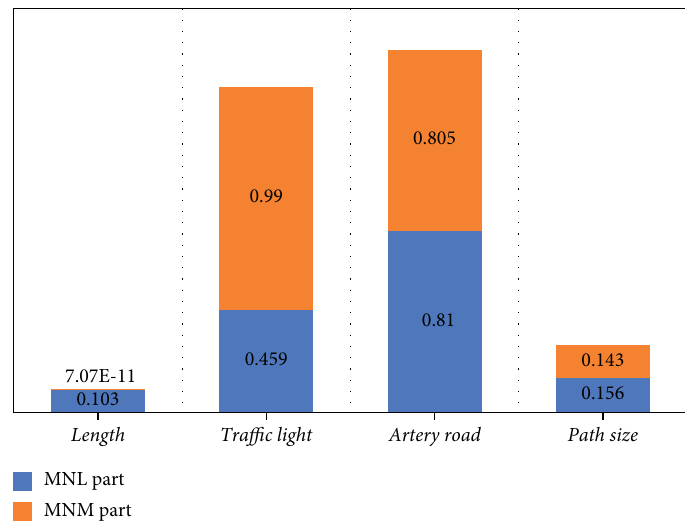
Figure 9: Average power coe ffi cient of each independent variable with both MNL part and MNM